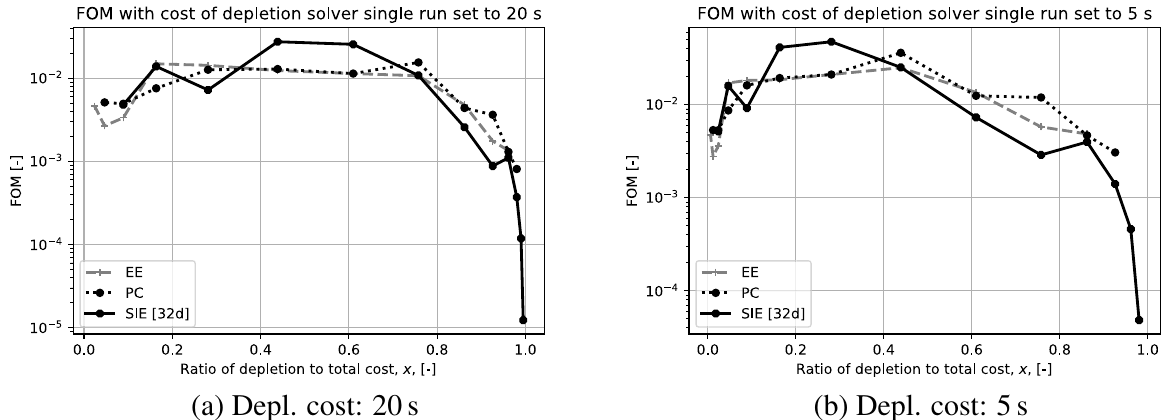
Figure 2: F OM vs x in simulations with two different costs of depletion